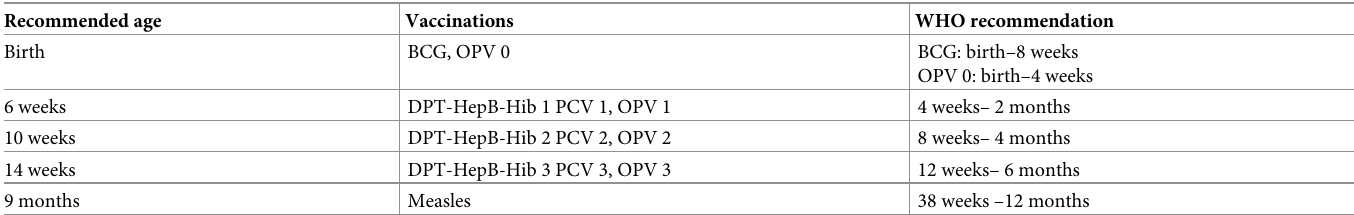
Table 1. The Ugandan expanded programme on immunisation schedule